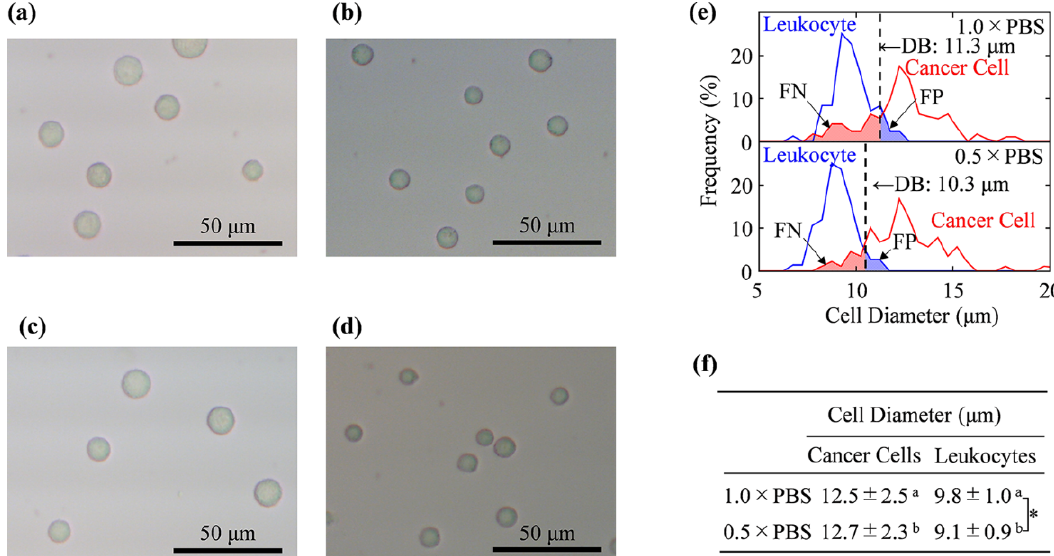
Figure 2. Cell size analysis by light microscopy. The microscope images of ( a ) cancer cells in 1.0 × PBS, ( b ) leukocytes in 1.0 × PBS, ( c ) cancer cells in 0.5 × PBS, and ( d ) leukocytes in 0.5 × PBS. ( e ) Histograms of the size distribution obtained for each cell evaluated using the microscopic images. ( f ) The average values and standard deviation for the cell diameters. The size of leukocytes in 0.5 × PBS is significantly smaller than that in 1.0 × PBS. A comparison between the two groups was performed using an unpaired t -test. The statistical significance is marked with * and a, b ( p <